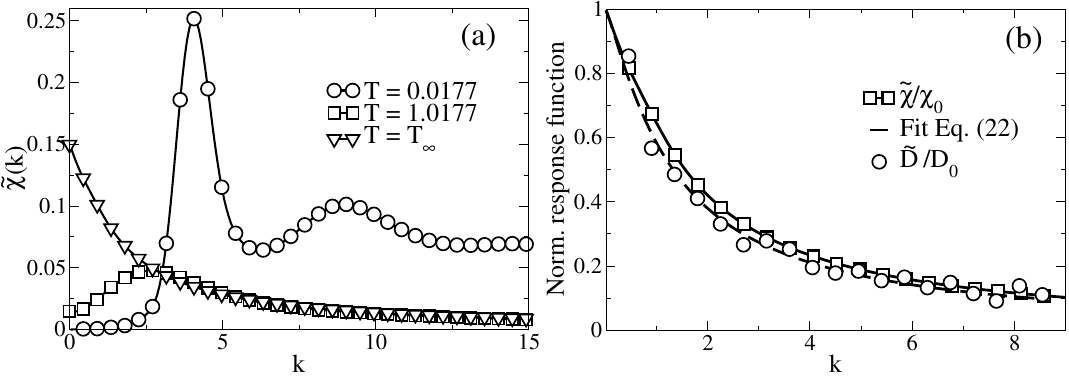
χ/χ and (cid:101) 0